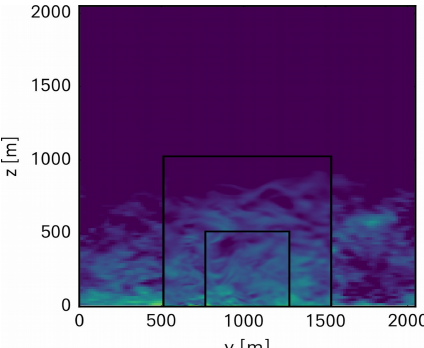
Figure 3. Vertical cross sections of wind speed in the three differ- ent nested LES runs. The coarsest runs use periodic lateral bound- ary conditions and large-scale forcing from ERA5. The higher- resolution runs use lateral boundary conditions from the “upper”